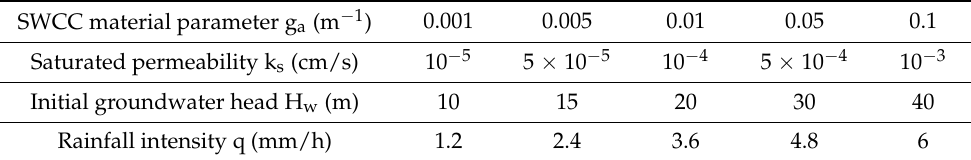
Table 3. Selected values of the investigated